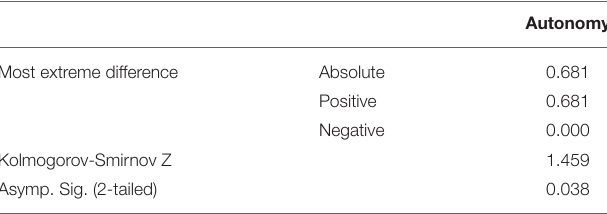
TABLE 4 | Kolmogorov–Smirnov test results of the index “autonomy”.